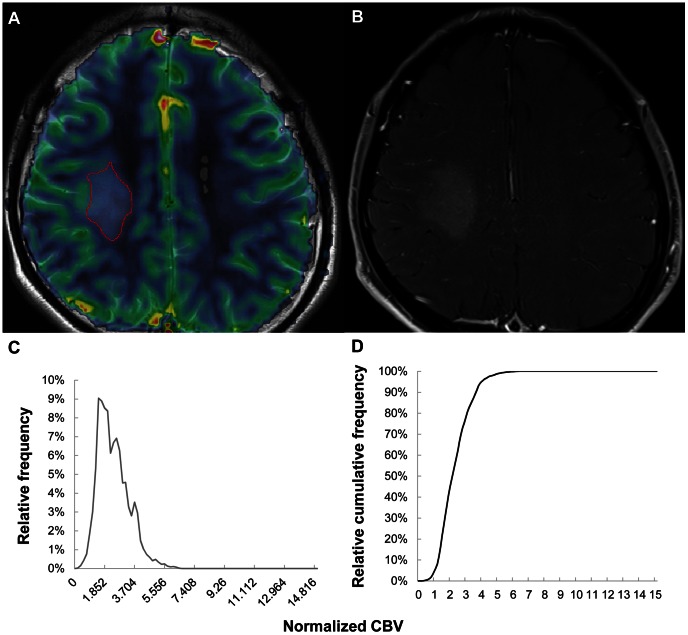
Images of a 35-year-old male with a grade III astrocytoma.(A) ROI-drawn rCBV map overlaid on a T2-weighted image, (B) contrast-enhanced T1-weighted image, (C) histogram of nCBV and (D) cumulative nCBV histogram. The 99th percentile value of the cumulative nCBV histogram was 5.092. ROI = region of interest; rCBV = relative CBV; nCBV = normalized CBV.